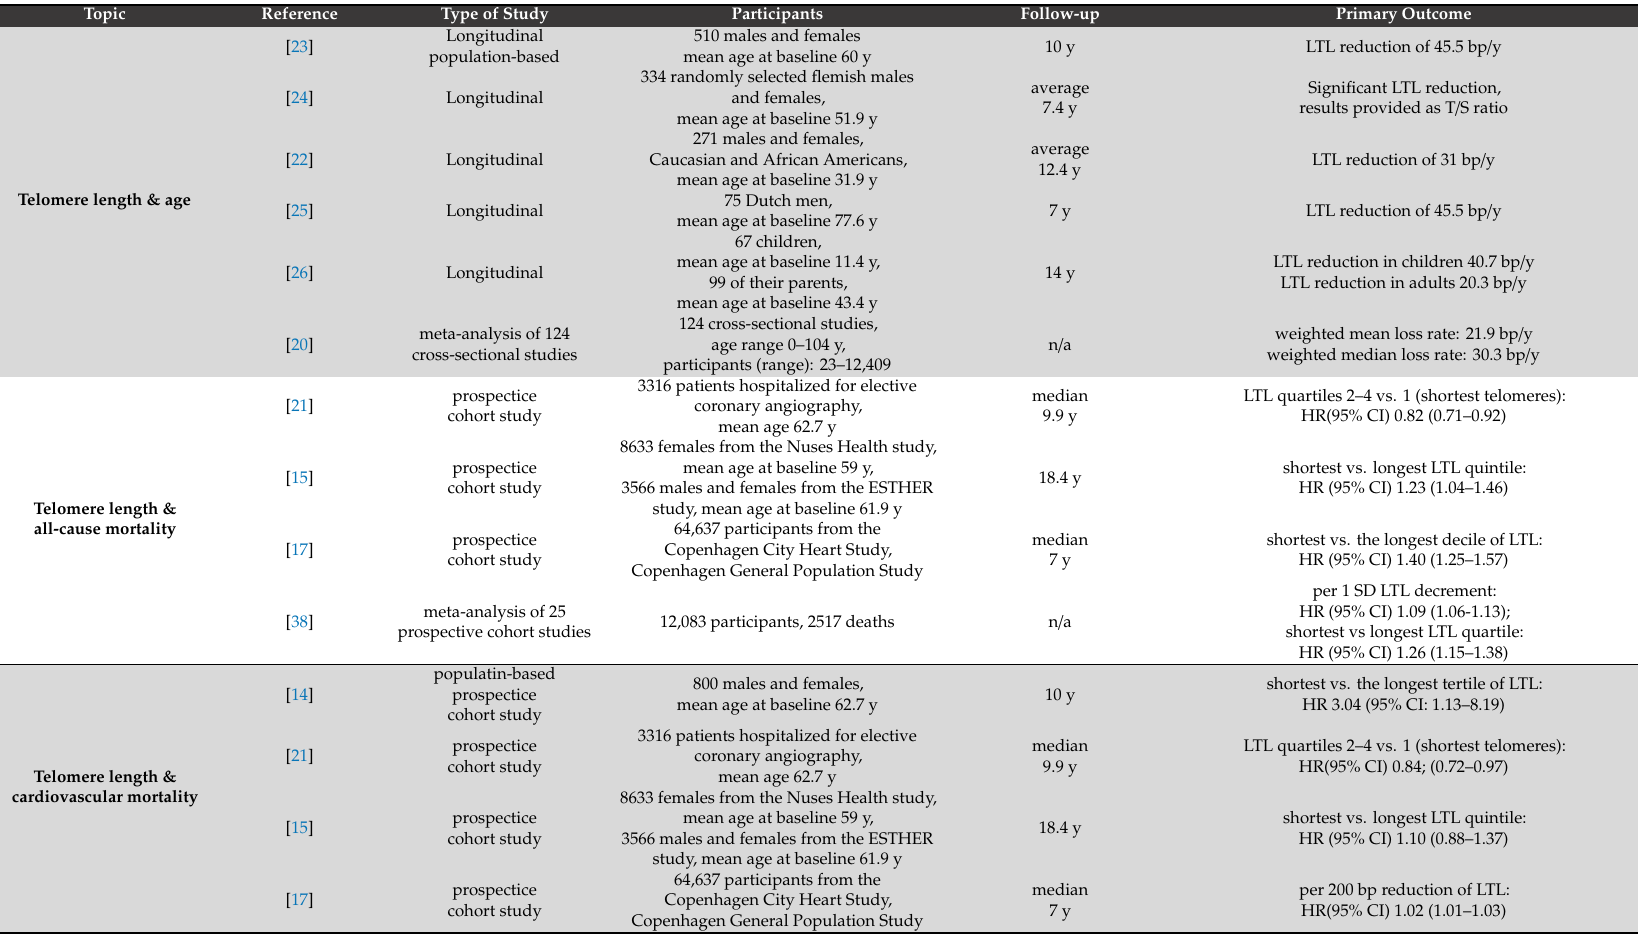
Table 1. Essential studies that investigated the role of telomeres in atherosclerosis and cardiovascular